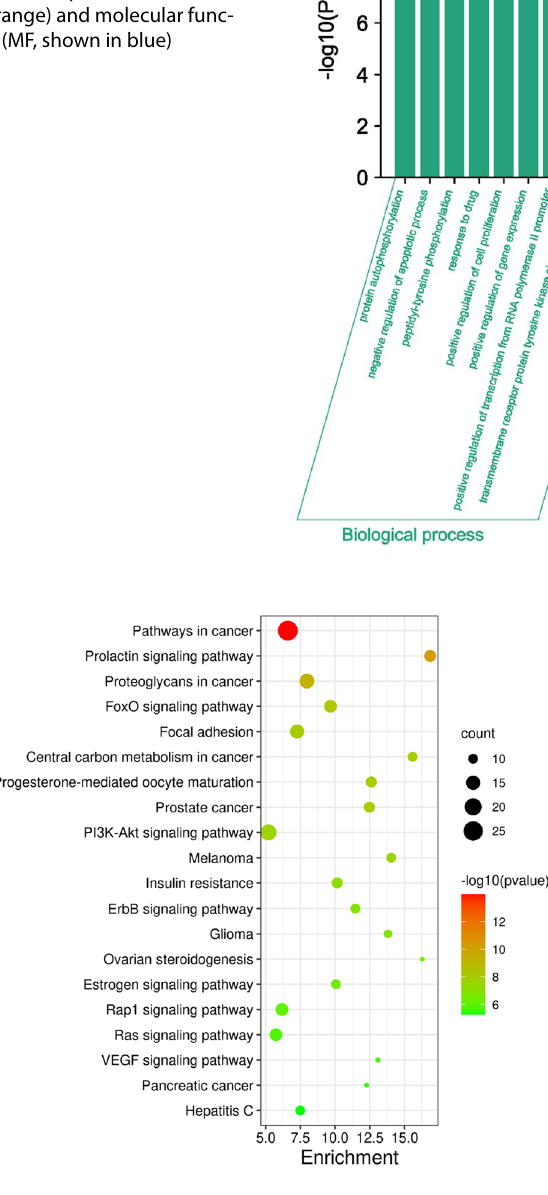
Fig. 3 Top 10 enriched items (p-value from low to high) for the 80 common targets (identi- fied in Sect. 3.2) in the three GO categories of biological process (BP, shown in green), cellular component (CC, shown in orange) and molecular func- tion (MF, shown in blue)